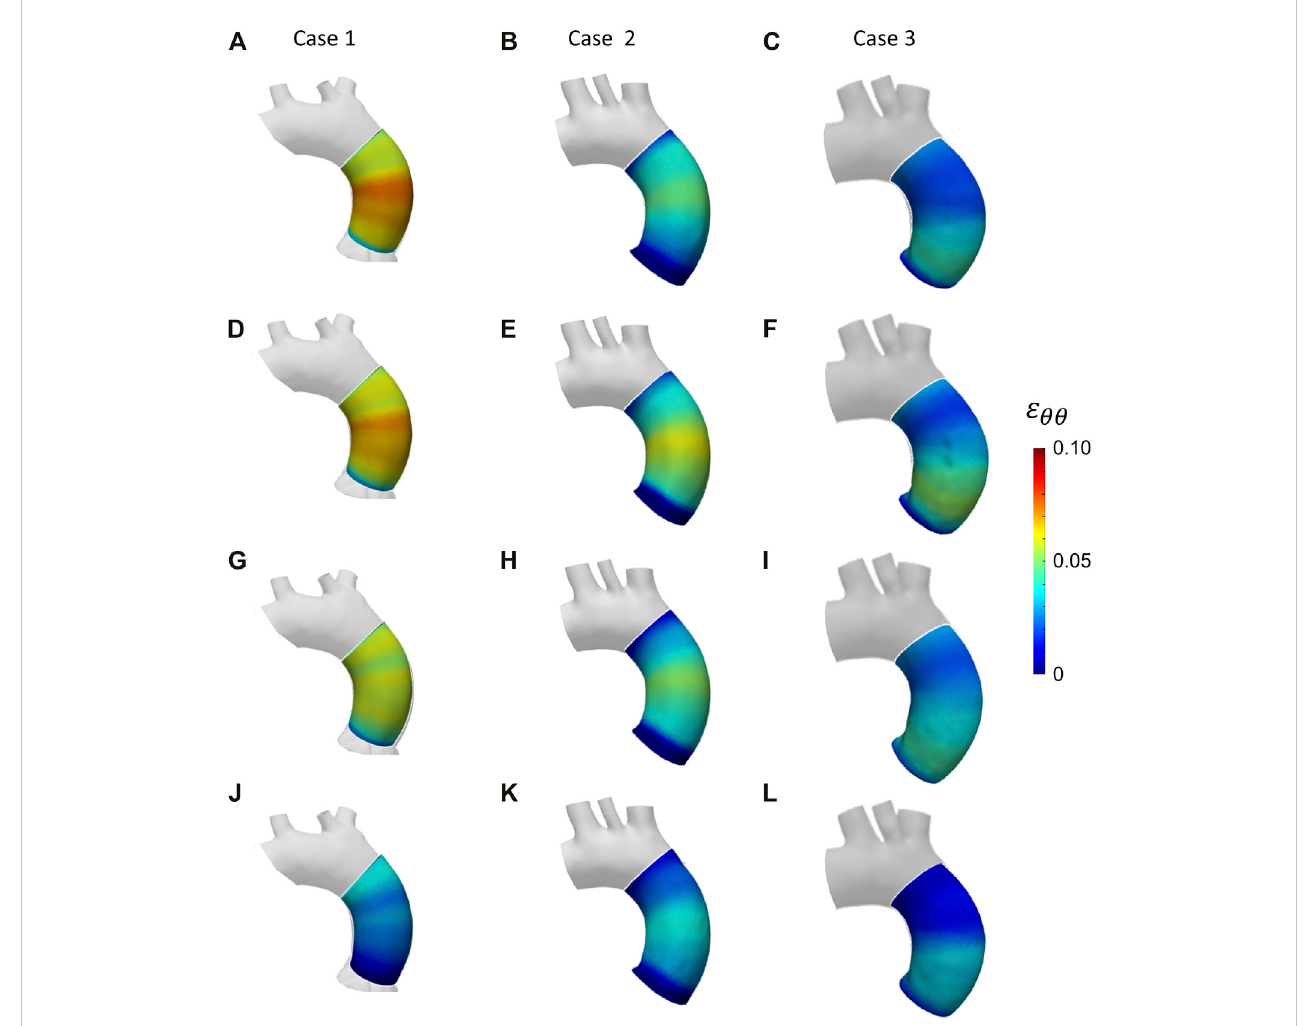
FIGURE 12 Circumferentialstrainmapsatthefourcardiacphases:20% (A – C) ;40% (D – F) ;60% (G – I) ;80%( J – L )frompatient-speci fi cCase1 (A,D,G,J) ,Case2 (B,E, H, K) and Case 3 ( C, F, I, L ).